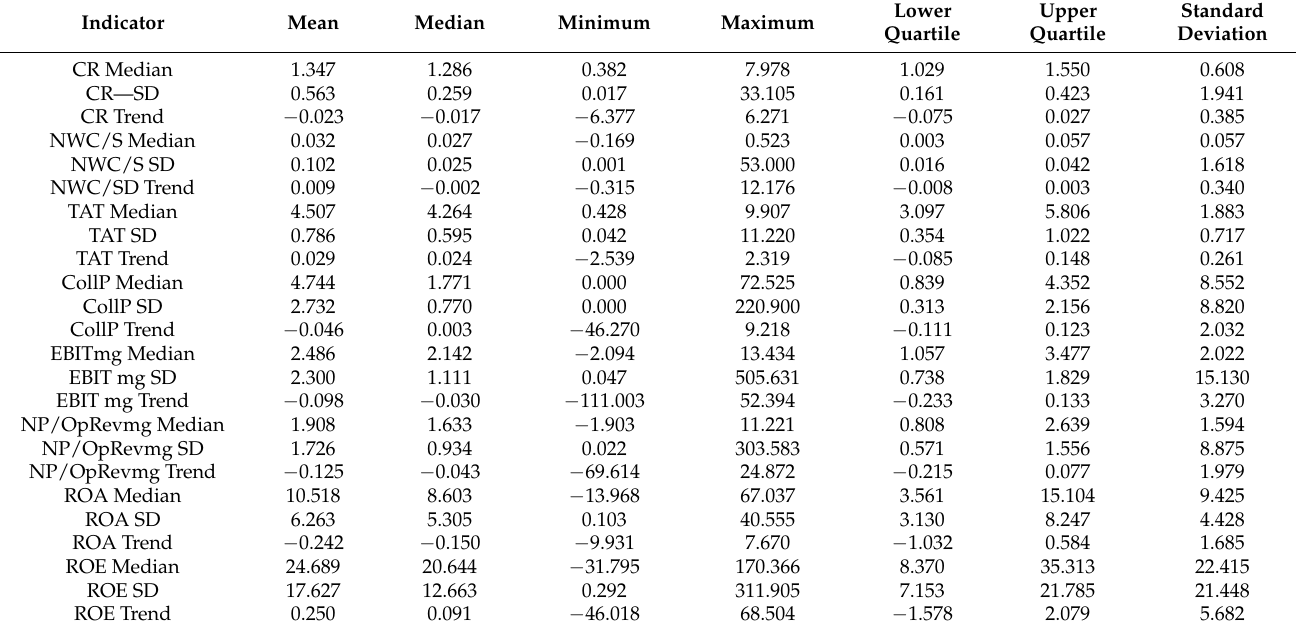
Table A4. Descriptive statistics of liquidity, efficiency, profitability, and aggregate performance indicators for medium solvency risk companies,